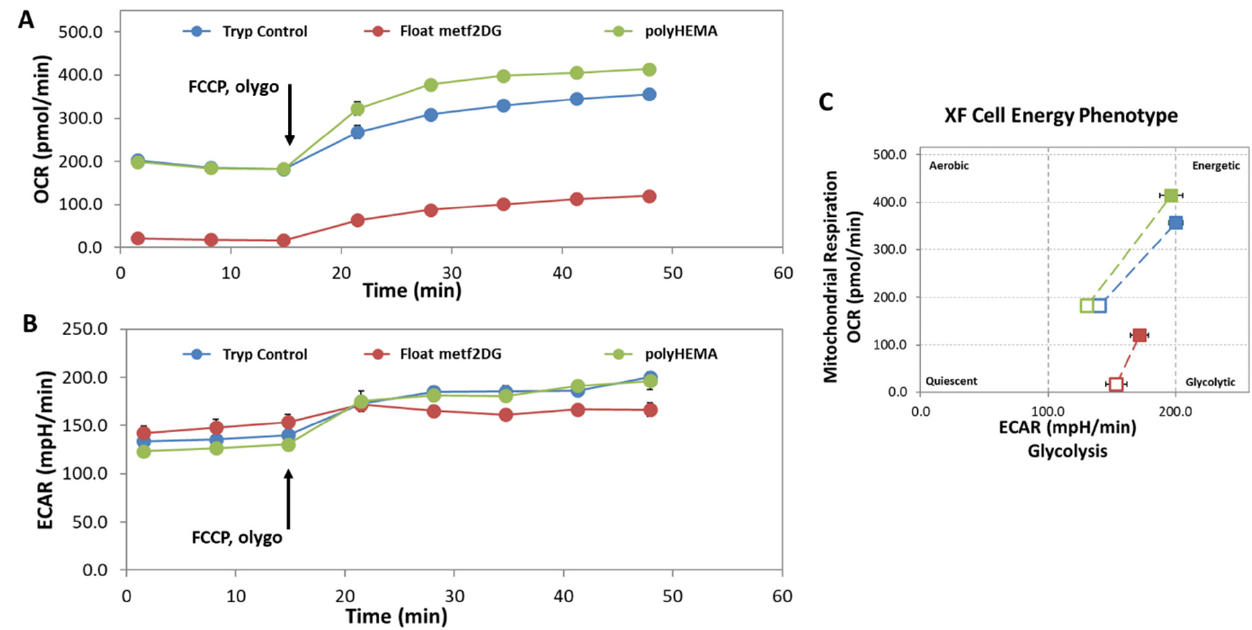
Figure 3. Metabolic alterations in met2DG-treated MDA-MB-231 cells. MDA-MB-231 cells were treated for 48 h with the 5 mM metformin and 0.6 mM 2DG. As a control, non-treated attached cells were harvested with trypsinization (Tryp Control) or grown on polyHEMA-coated flasks (polyHEMA). Following treatment, the cell energy phenotype of the floating met2DG